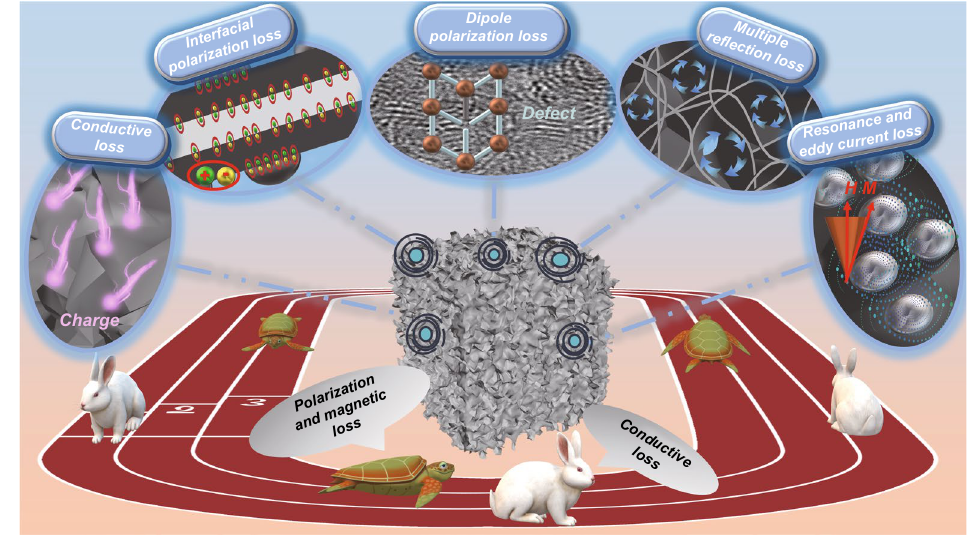
Fig. 7 Possible EMW absorption mechanisms for